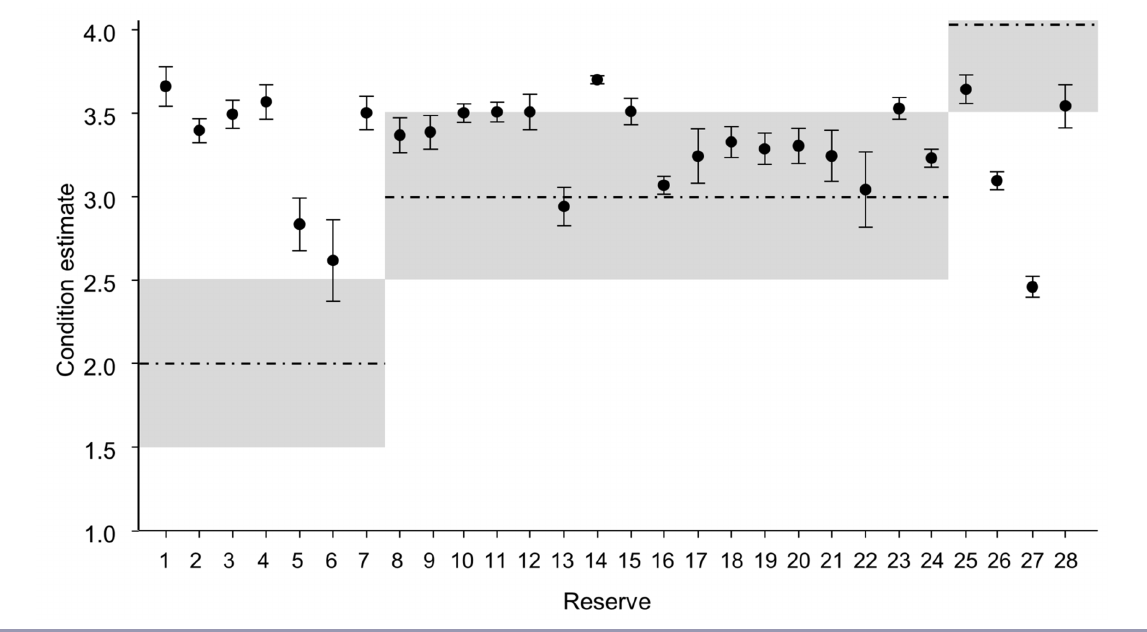
Fig. 2 . The condition estimate for each vegetation type sampled. The circles represent the mean empirical condition scores, with standard error bars. The dashed lines indicate the corresponding condition score provided by practitioners, while the areas of grey shading provide a rounding error of ± 0.5 around the practitioners’ visual estimates (n =